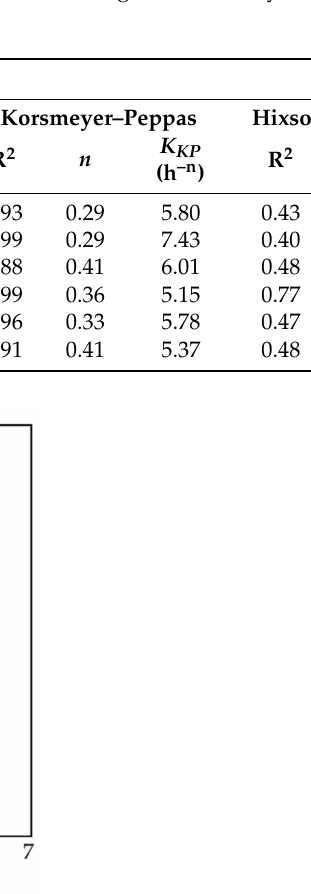
Figure 14. Fit of experimental data of hydrocortisone release for PMAA 1 ( (continuous line).